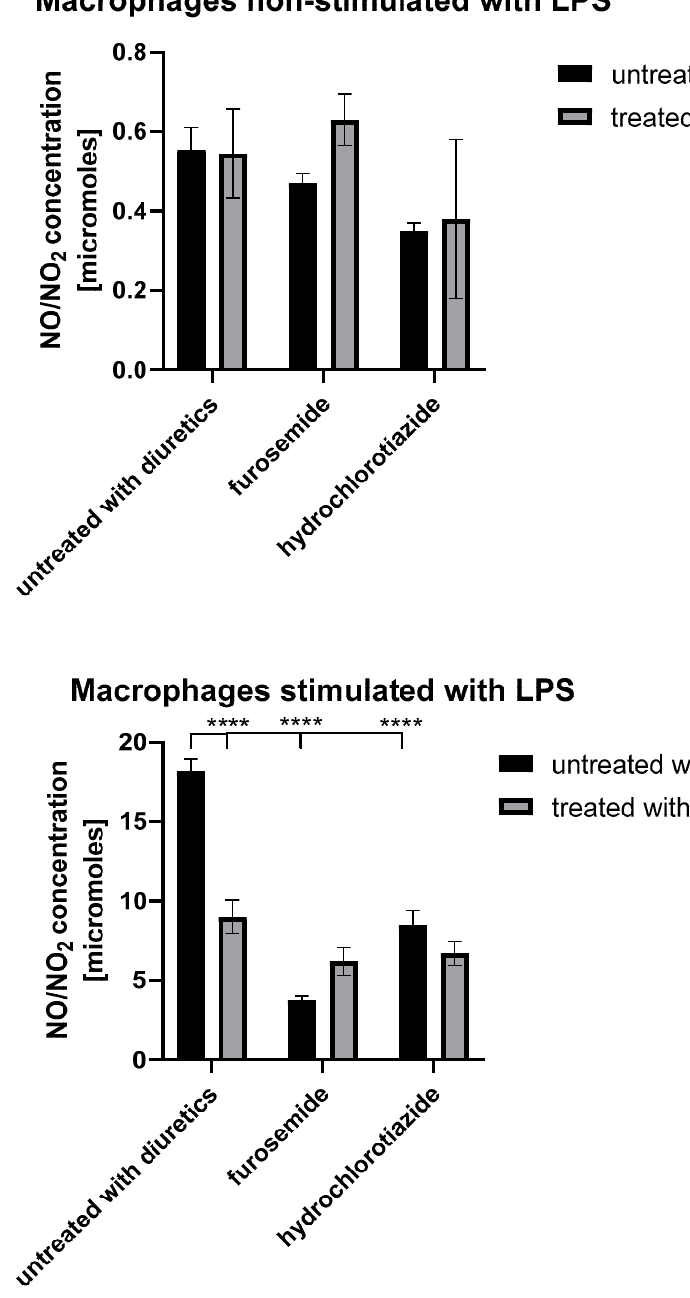
Figure 5. Nitric oxide (NO) secretion by macrophages harvested from drug-treated mice. Oil-induced peritoneal macrophages from mice treated with captopril with or without a respective diuretic drug were cultured in standard conditions, in some cases after stimulation with LPS (200ng). Griess-based colorimetric reaction was then used to measure the concentration of NO/NO2 in supernatant collected after 24h of the culture. Results were expressed as mean (+/ − SD) per group. Two-way ANOVA with Tukey’s post hoc test. **** p < 0.001, n = 3, N = 3.